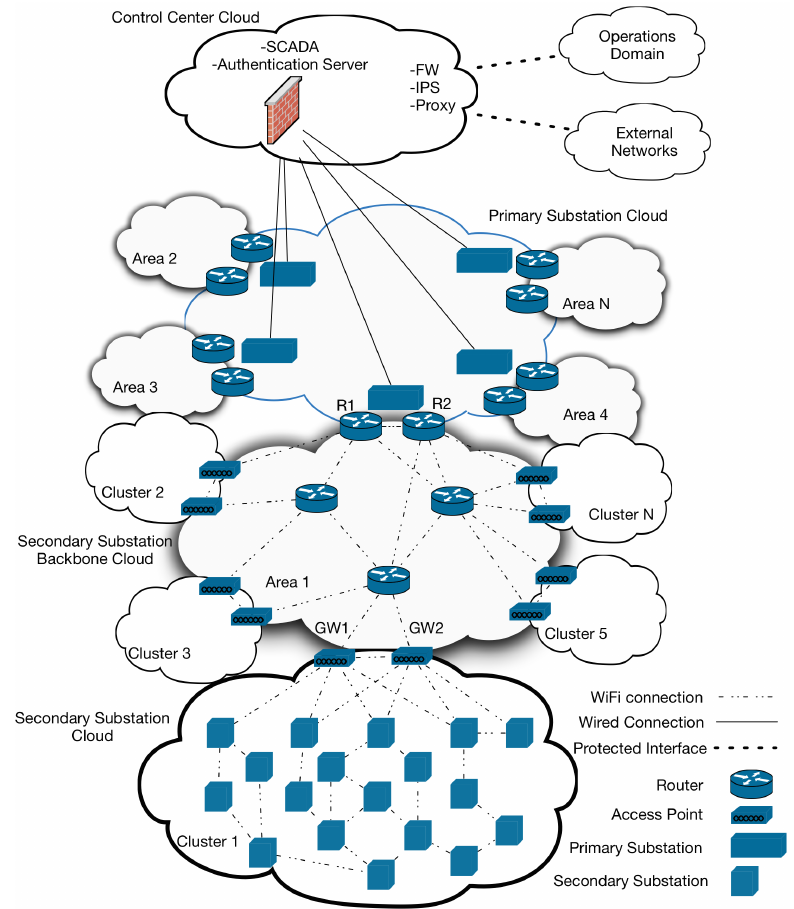
Figure 3. Security Aware Distribution System